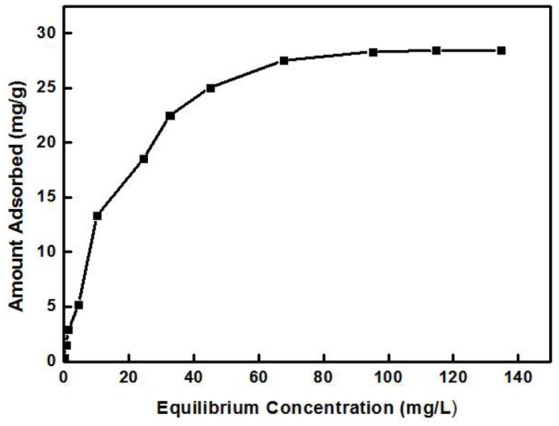
Adsorption isotherm equations of Cd2+.